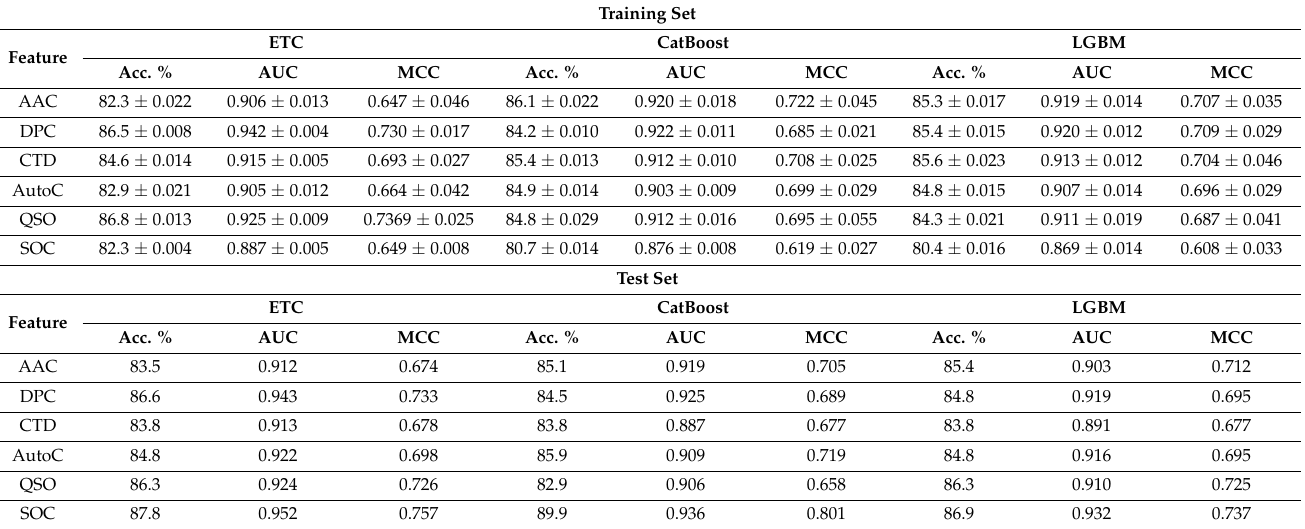
Table 1. Performances of machine learning models based on single-feature types for the benchmark training and test datasets. Values shown are the mean ± standard deviation for the training dataset. Training